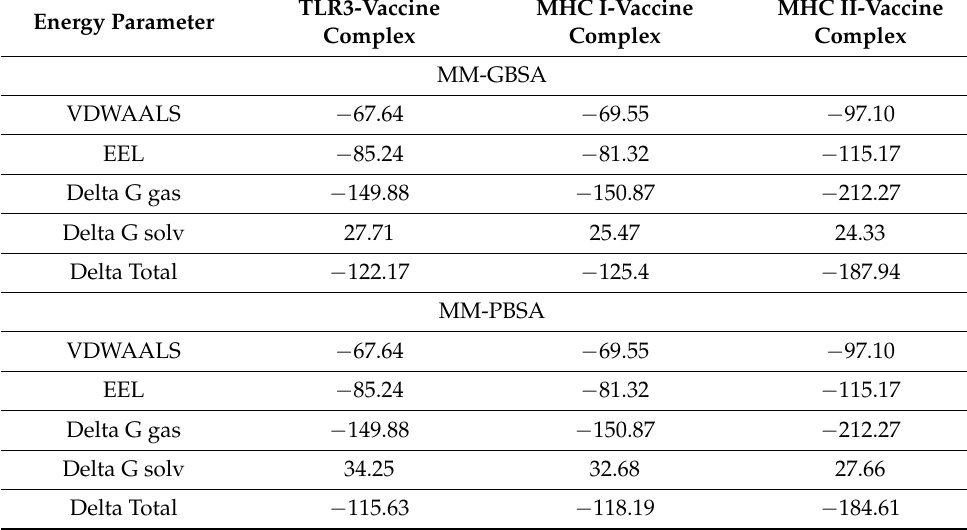
Table 5. MM-GBSA-based energy parameters of the complexes (TLR3-vaccine, MHC I-vaccine, and MHC II-vaccine), with the net delta energy given in